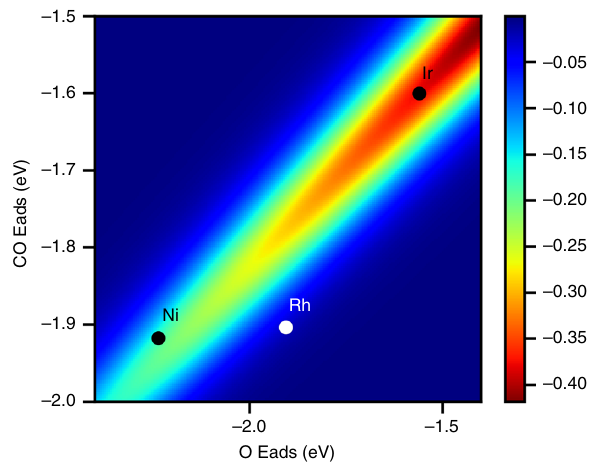
Fig. 8 Error in predicted CO coverage. Error is without scaling of G vib at 400 K, 1 bar and 100 ppm CO in O 2 based on vibrational contributions for CO and O on Pd(111) at the fcc hollow site. x and y axes correspond to electronic adsorption energy calculated using the RPBE functional with D3 dispersion corrections. The color indicates the error in coverage, with the highest possible coverage of 1. Lack of vibrational scaling lowers the CO coverage